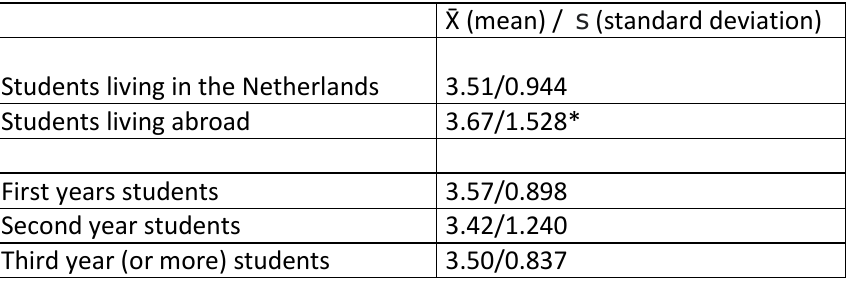
Table 4 "I have a sense of belonging within the Honours community"; N=48 .